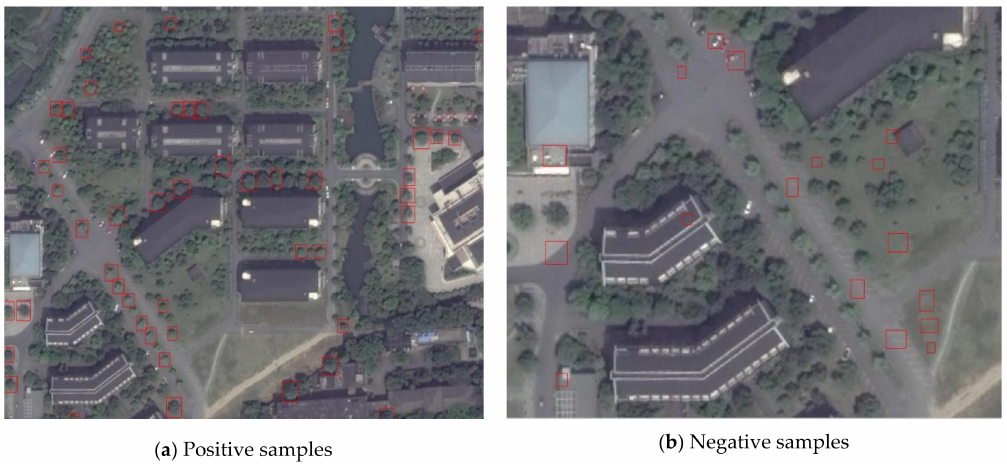
Figure 3. Calibration of samples.